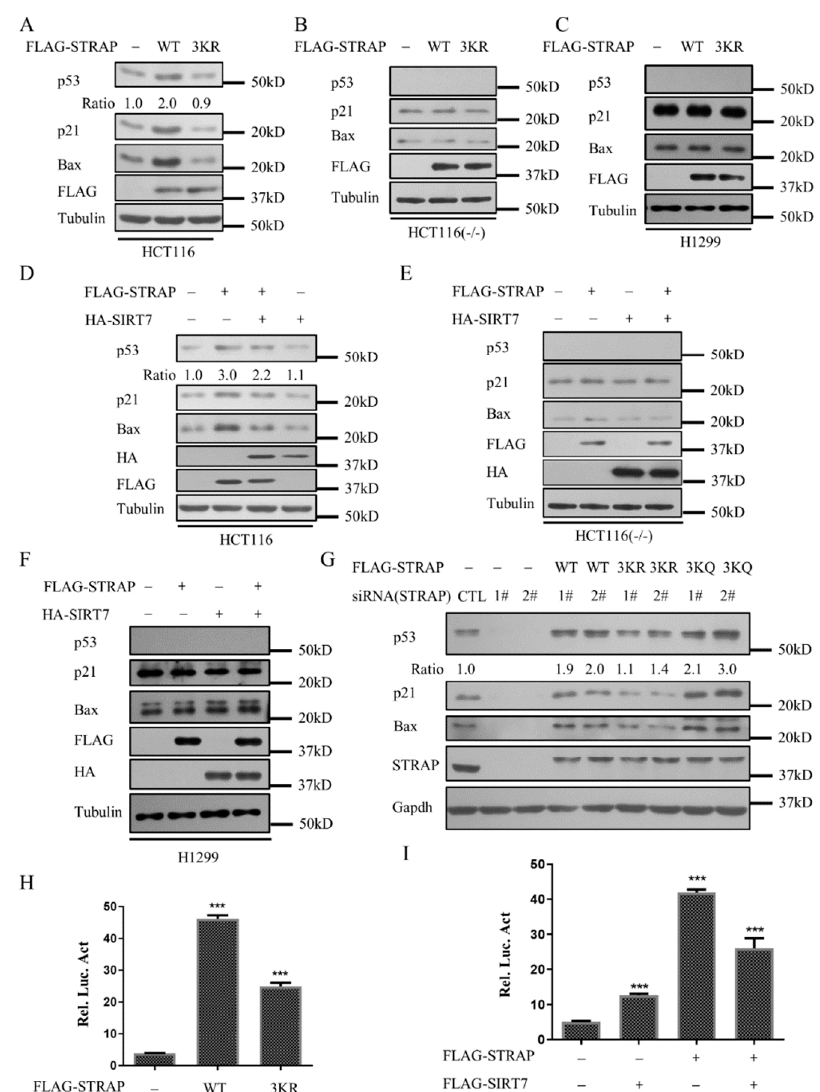
Figure 4. Acetylation of STRAP regulates p53-mediated transcription. ( A – C ) Effect of STRAP acetylation on the expression of p53 target genes. HCT116 (wild-type), H1299, and HCT116 (p53 -/-) cells were transfected with the indicated plasmid vectors expressing a control vector (Vector), STRAP-